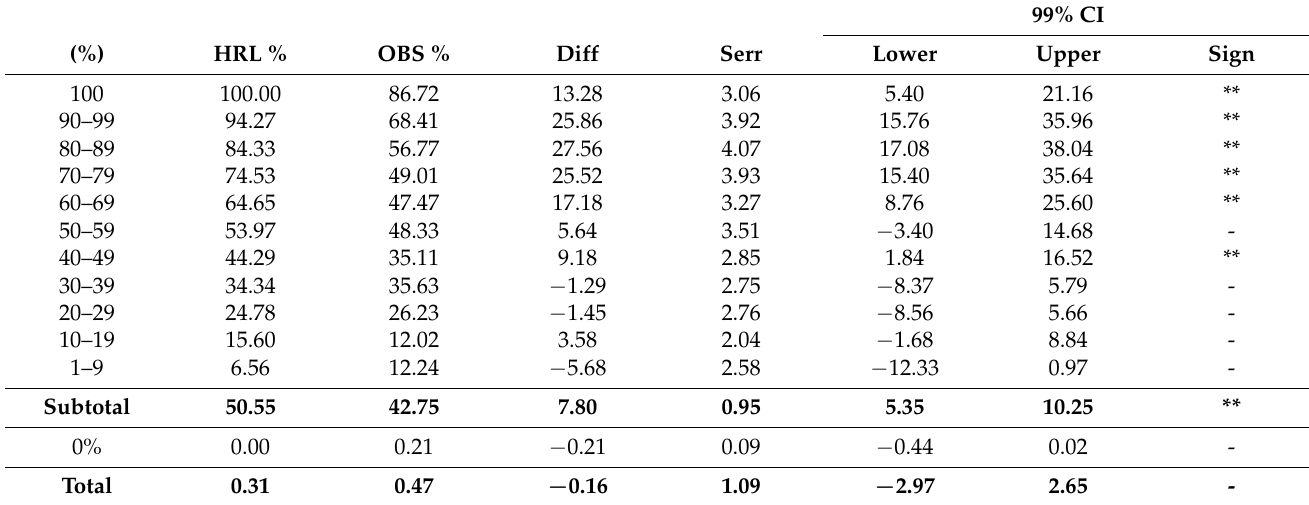
Table 2. Difference (Diff) between the imperviousness reported by HRL IMD (HRL %) and observed on orthophotos (OBS %) calculated by stratum. SErr is the standard error of the difference, and the 99% CI is the confidence interval for the difference. Sign shows the result of the test of the hypothesis Diff (cid:54) = 0. The null-hypothesis (Diff = 0) is either not rejected (-) or rejected with 99% confidence